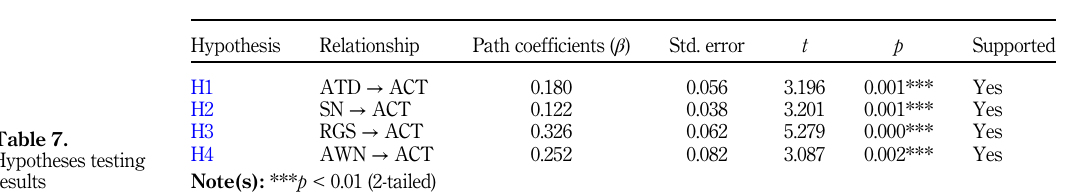
Table 7. Hypotheses testing